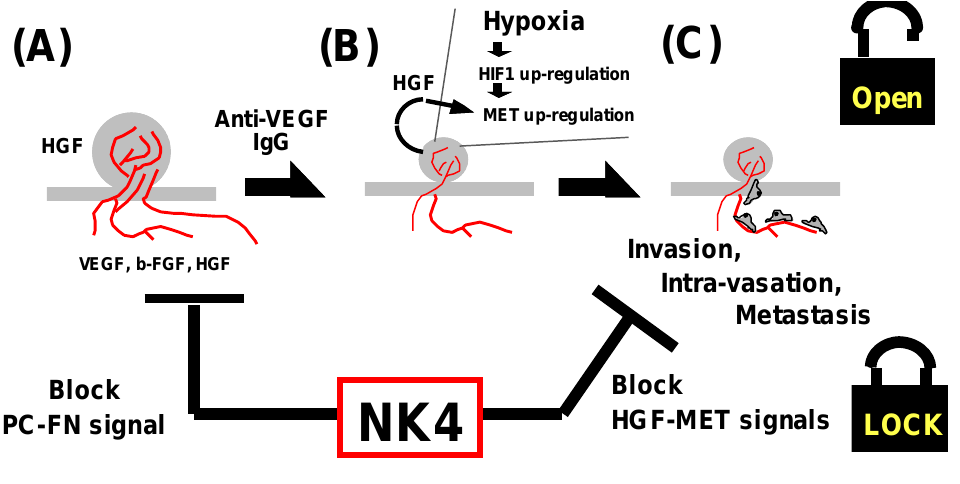
Figure 6. Freeze and dormant therapy of malignant tumors by NK4, an HGF-antagonist and angio-inhibitory agent. ( A ) Primary tumors show invasive growth under the support of vascular formation, mediated by VEGF, b-FGF and HGF. Stroma-secreted HGF also supports tumor growth and invasion via activations of Ras and β-catenin pathways; ( B ) Anti-angiogenic strategies, using anti-VEGF antibody, lead to tumor hypoxia and regression in a short period. The local hypoxia upregulates MET via HIF1-mediated cascades; ( C ) Under such a hypoxic condition, MET-expressing cancer cells migrate to adjacent vessels in response to HGF. Thus, NK4 is reasonable for suppressing hypoxia-mediated tumor progression: (i) in the early-stage, NK4 reduces tumor angiogenesis via inhibiting binding of fibronectin (FN) to perlecan (PC); and (ii) in the late-stage, NK4 blocks the HGF-mediated cancer invasion and metastasis as an HGF-antagonist. Such a dual property of NK4 produces “freeze and dormancy” therapy against tumor